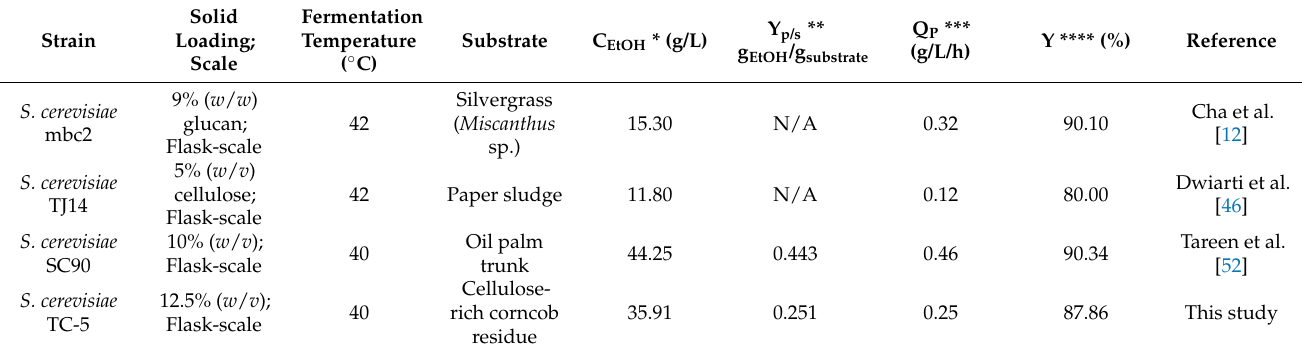
Table 2. Comparison of bioethanol production from S. cerevisiae using lignocellulosic biomass via simultaneous saccharifica- tion and fermentation